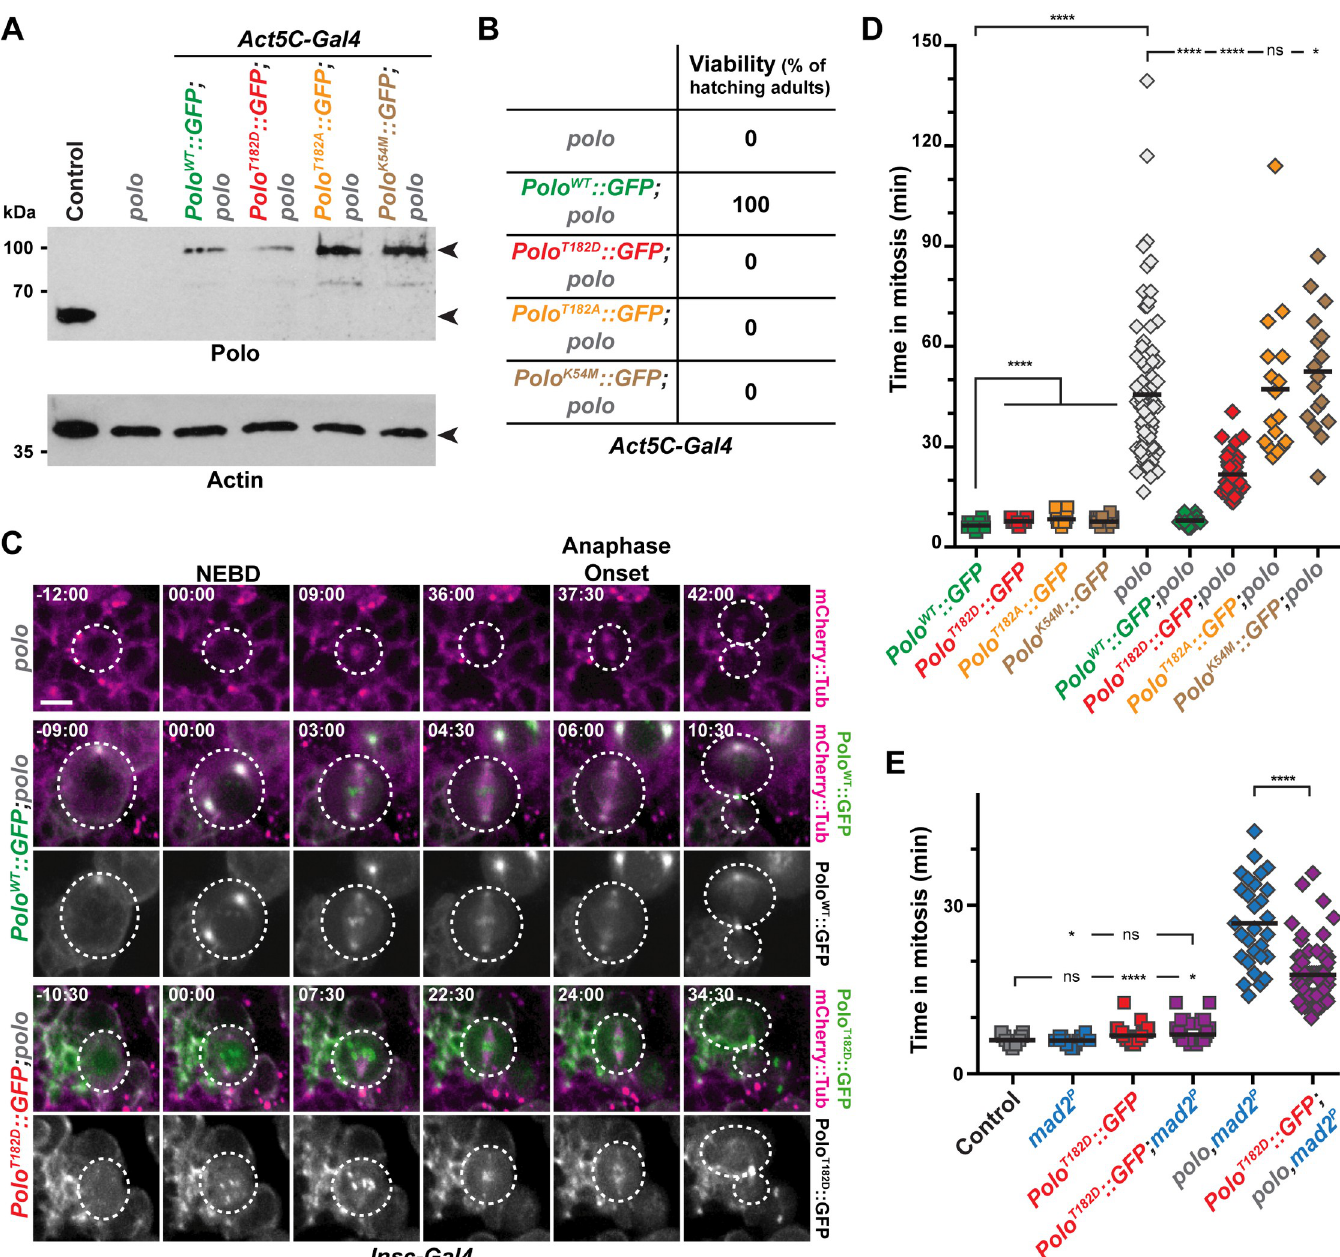
Fig 2. Constitutive Polo kinase activity is not compatible with normal mitosis duration and Drosophila viability. A) Polo and Actin Western blot analyses showing the expression of endogenous Polo kinase in control and GFP-tagged Polo variants (WT, T182D, T182A and K54M) expressed ubiquitously in polo mutant brains. The genotypes are indicated for each lane. Actin was used as a loading control. B) Hatching rates of polo mutants expressing the indicated Polo variants. C) Time-lapse imaging of mitosis in polo mutant NSCs expressing the indicated Polo variants and mCherry::Tubulin. The white dashed lines outline the dividing NSCs. Scale bar: 5 μ m. Time is min:s (t = 00:00 is NEBD). D-E) Quantification of the time in mitosis of NSCs of the indicated genotypes. Means are shown as black bars. Mann-Whitney unpaired test: ns: p > 0.05; � : p < 0.05; ���� : p <